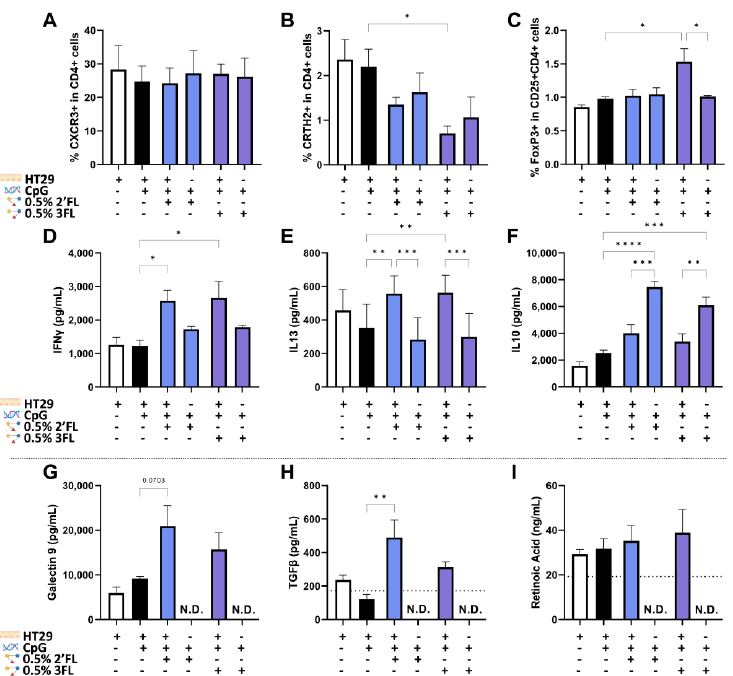
Figure 6. The role of IEC in HMOS plus CpG mediated immunomodulation. This was assessed by comparing PBMC that were exposed to 2′ FL and 3FL combined with CpG in absence or presence of IEC in the transwell. Th1-type, Th2-type and Treg cells were assessed by expressing ( A ) CXCR3 in CD4 + cells, ( B ) CRTH2 in CD4+ cells and ( C ) FoxP3 in CD25 + CD4+ cells. In addition, secretion of ( D ) IFN γ , ( E ) IL13, and ( F ) IL10 in the basolateral compartment was determined after exposure to 2′ FL and 3FL combined with CpG in absence or presence of IEC. In addition, epithelial-derived ( G ) galectin-9, ( H ) TGFβ and ( I ) retinoic acid were measured when IEC were set apart after coculture. Basal concentrations in culture medium are indicated with the dotted line, N.D. is mentioned when concentrations were not determined. Data is analyzed by One-Way ANOVA followed by a Bonferroni post-hoc test, n = 3, mean ± SEM (* p < 0.05, ** p < 0.01, *** p < 0.001, **** p <